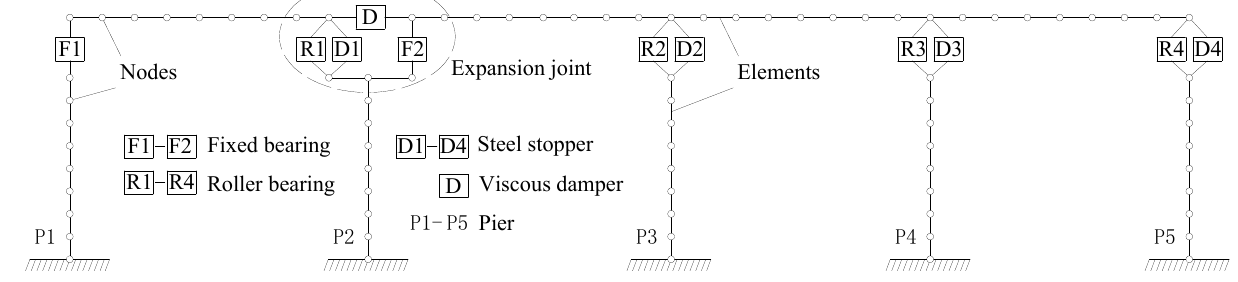
Figure 4. Elevation view of finite element model of curved viaduct.